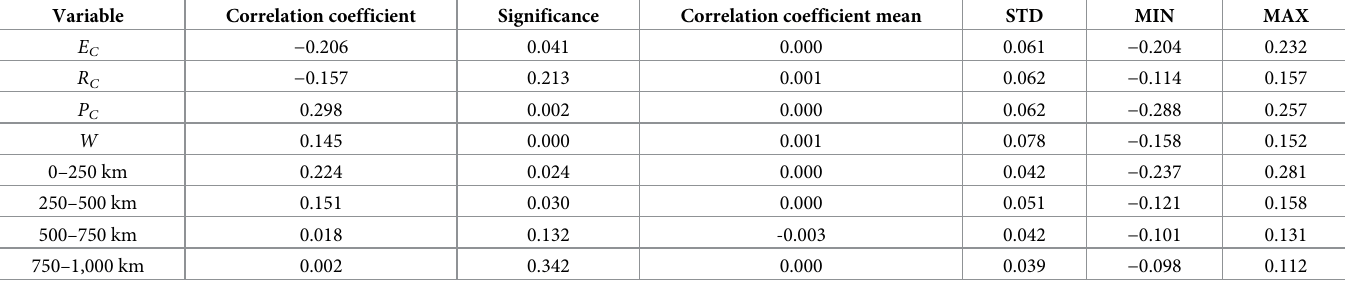
Table 6. QAP correlation